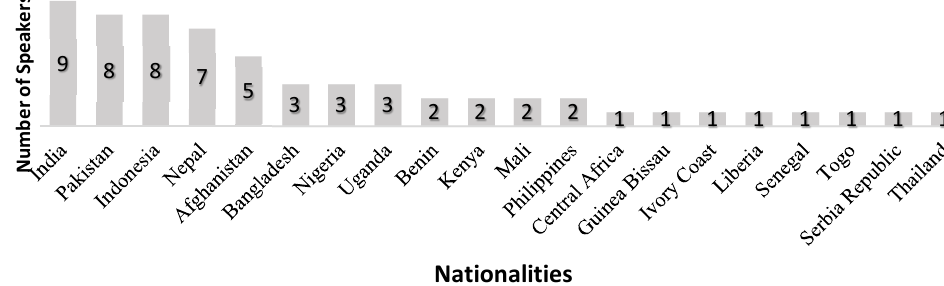
Figure 1. Nationality distribution of all speakers.